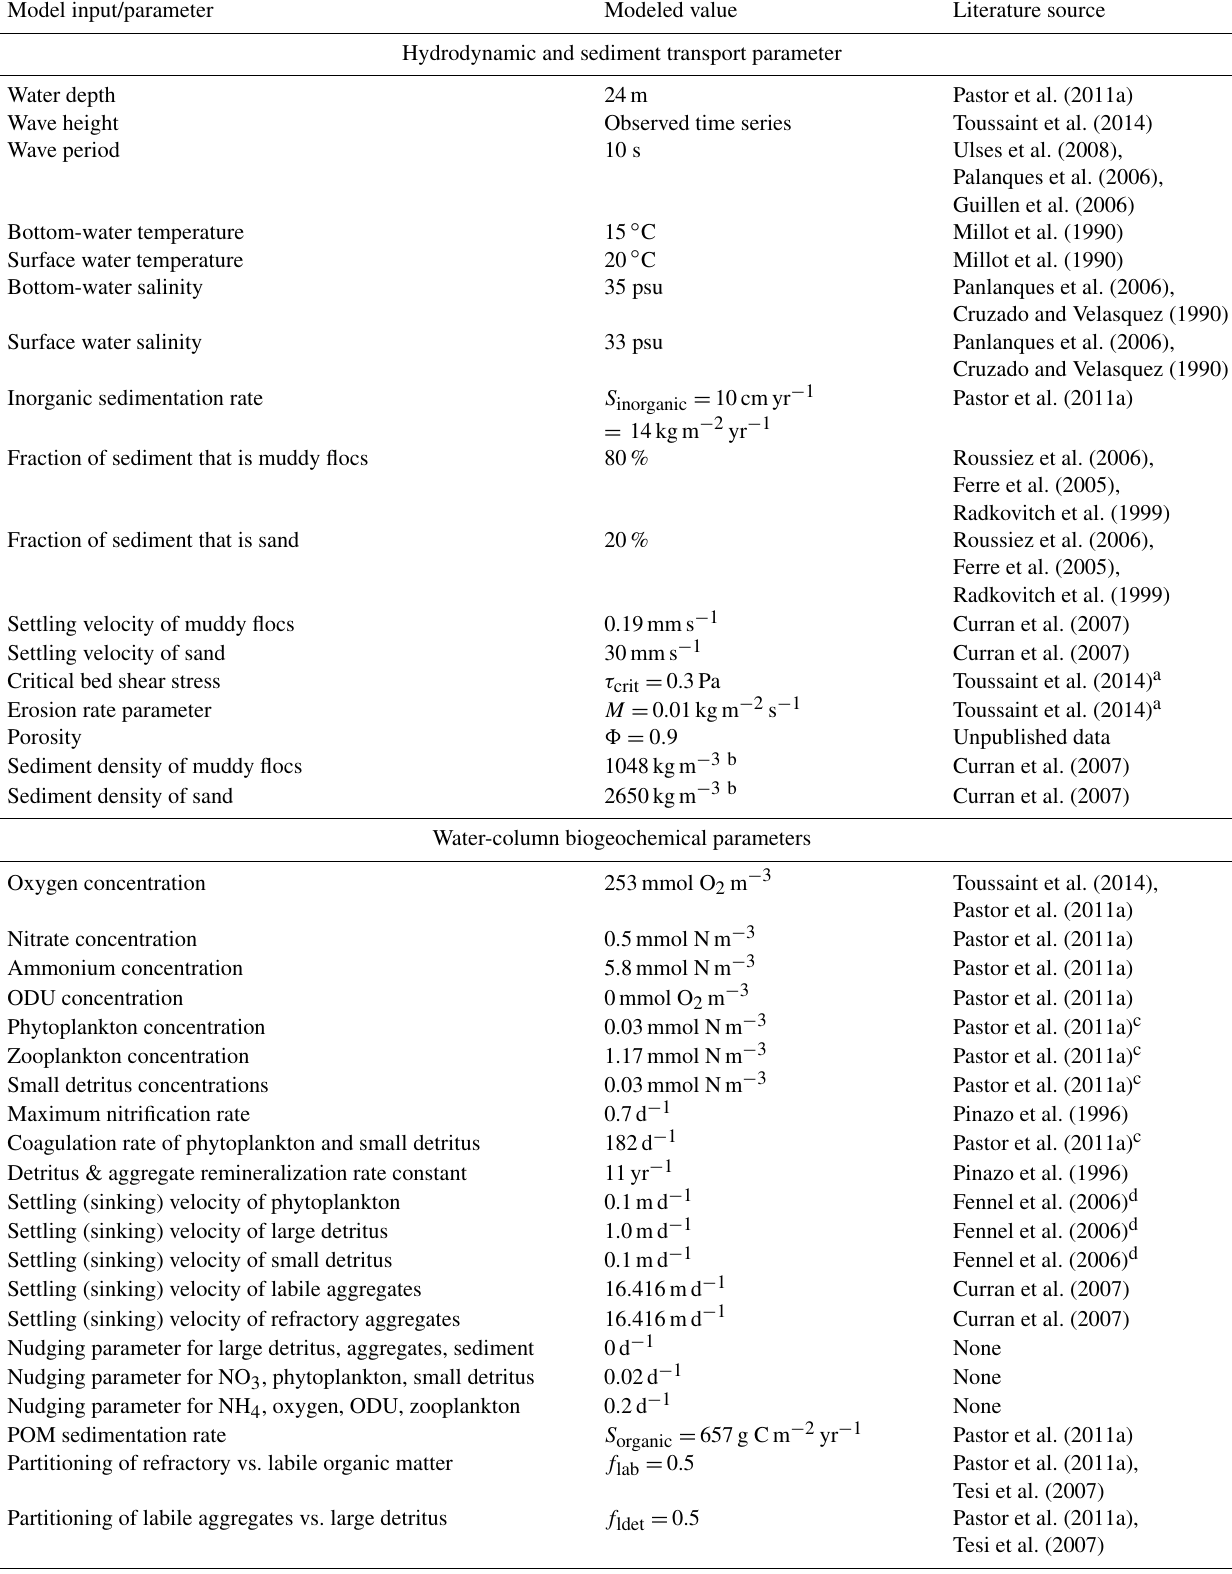
Table 3. Environmental conditions and parameters for the Standard Model